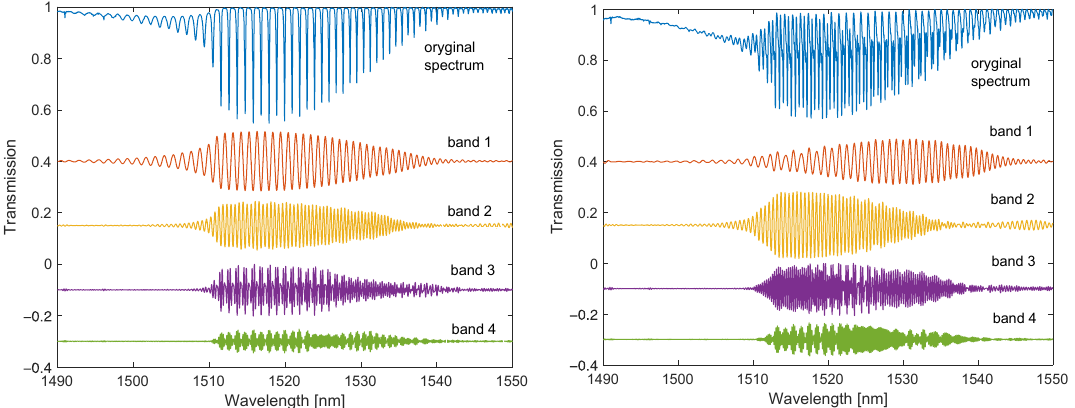
Figure 10. Optical spectra: original and filtered for individual frequency bands for TFBG and DC-TFBG (SRI = 1.3701). Figure 11. Optical spectra: original and band-filtered for individual frequency bands for TFBG and DC-TFBG (SRI = 1.4012).